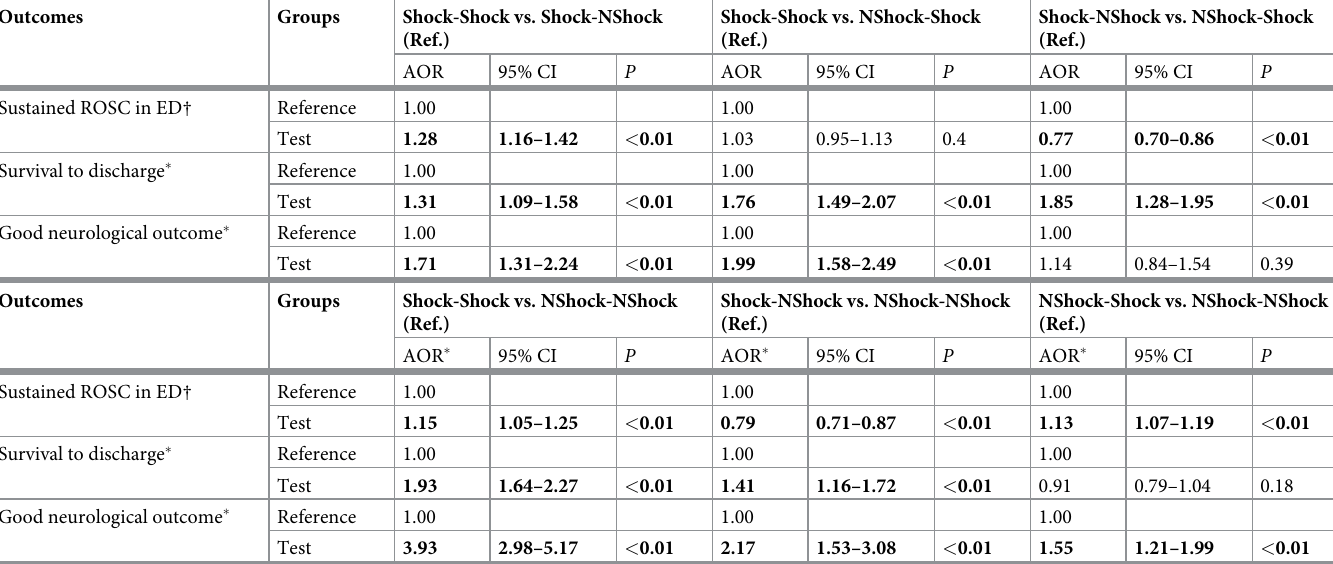
Table 3. Multivariable logistic regression analysis for the propensity score-matched sample between four groups for outcomes. Outcomes